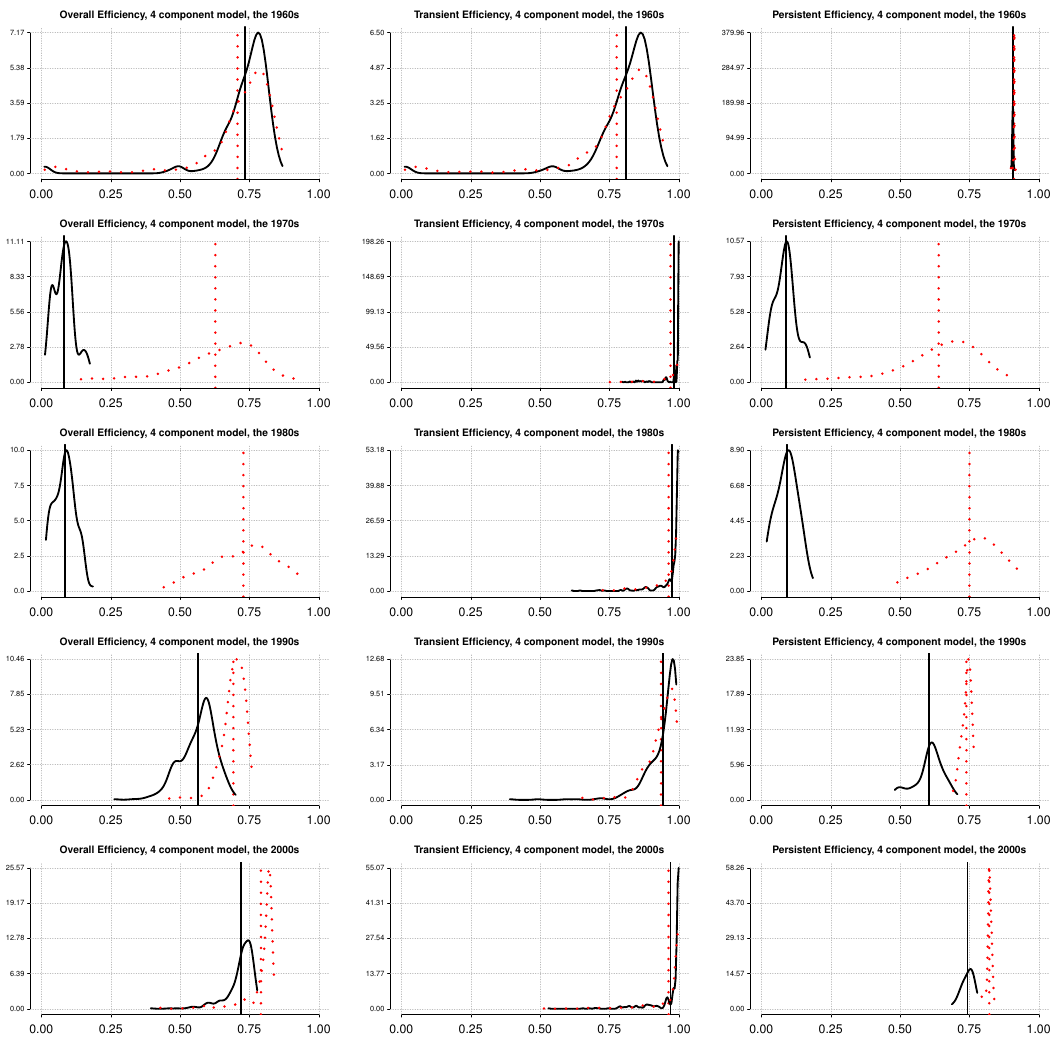
Figure 6. Overall, transient and persistent energy efficiency, Model 3. Notes: Solid black curves are high energy-intensive industries, dotted red curves are low energy-intensive industries. Vertical lines are respective mean